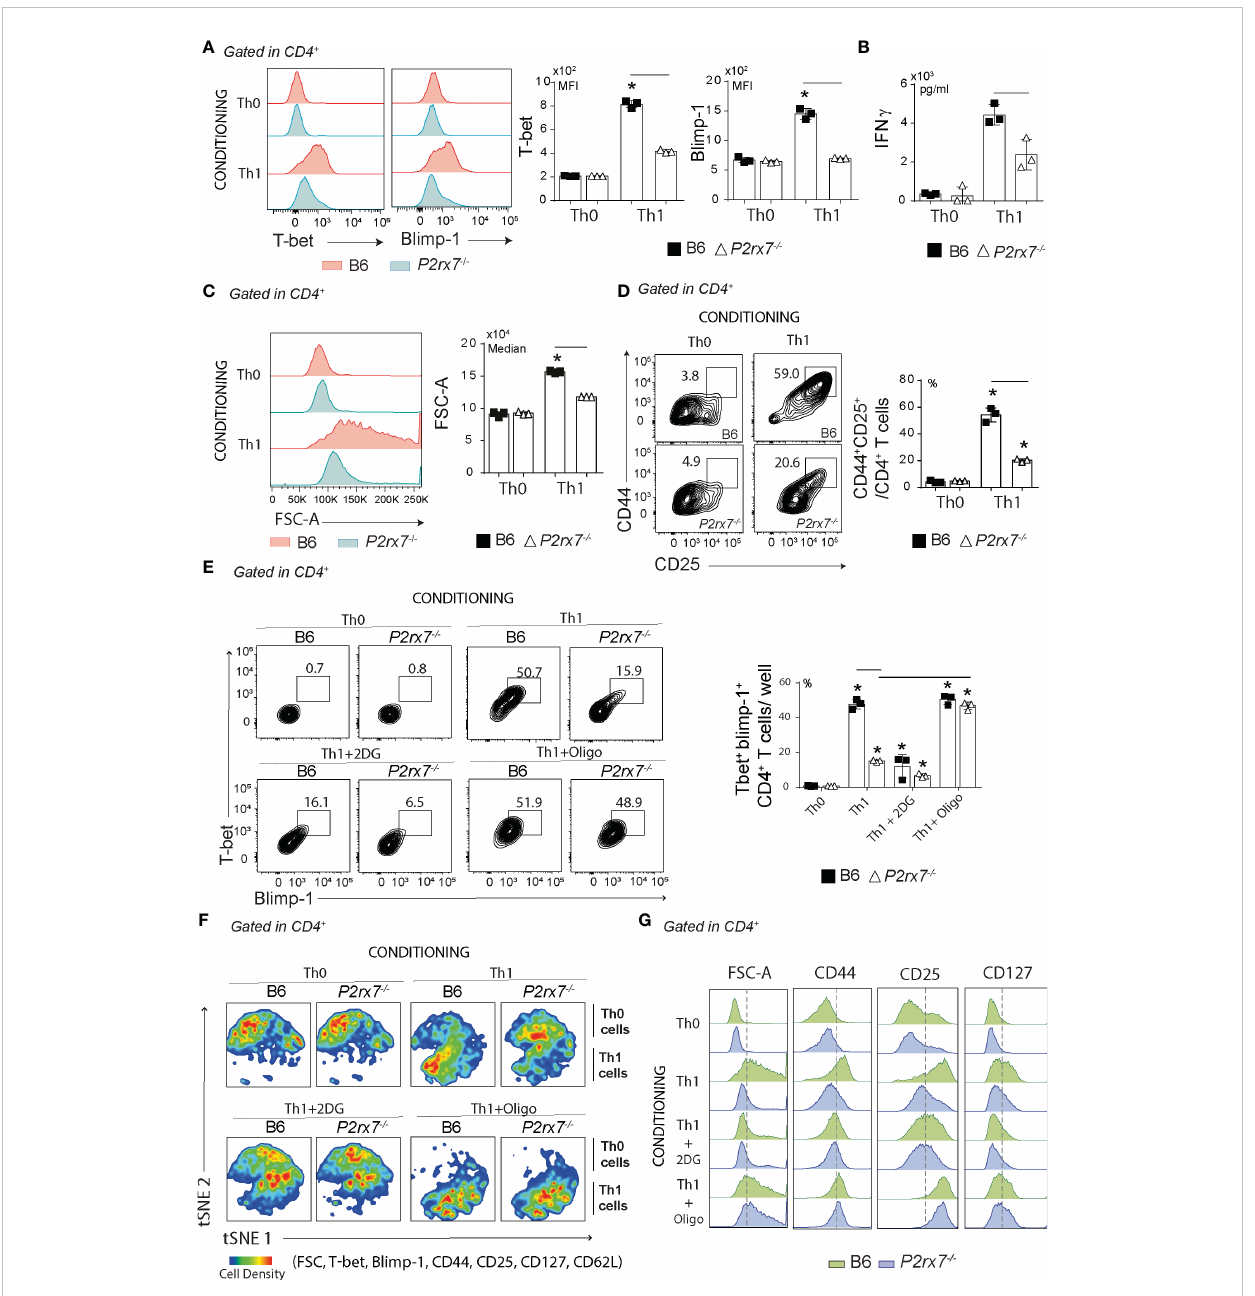
FIGURE 4 Effects of glycolytic pathway and ATP synthase inhibition in vitro on Th1-conditionated CD4 + T cells that express or not P2RX7. Splenic naïve CD4 + T cells from B6 and P2rx7 -/- mice were activated in vitro under Th1 conditions. Th0 condition was used as control. (A) Histograms show T-bet and Blimp-1 expression in CD4 + T cells under Th0 or Th1 conditions. Column bar graphs show T-bet and Blimp-1 MFIs. (B) Column bar graph shows IFN g production. (C) Histogram shows FSC-A of CD4 + T cells and the medians are shown in the column bar graphs. (D) Contour plots show